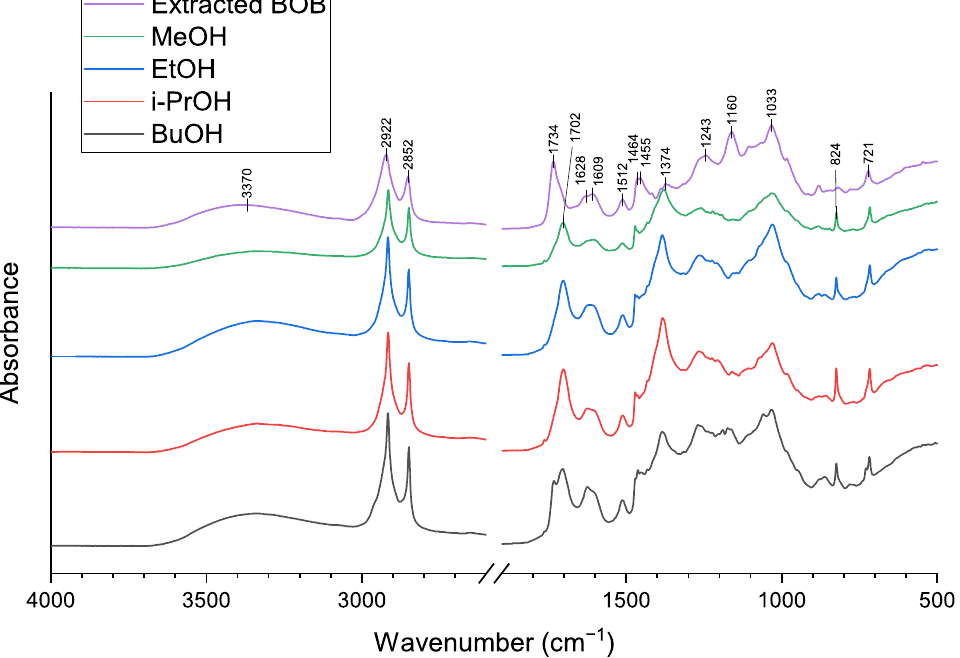
Figure 4. FT-IR spectra for adhesive samples and feedstock (extracted BOB).